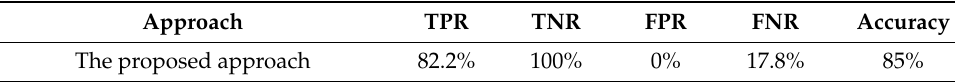
Table 5. Performance of the proposed system.